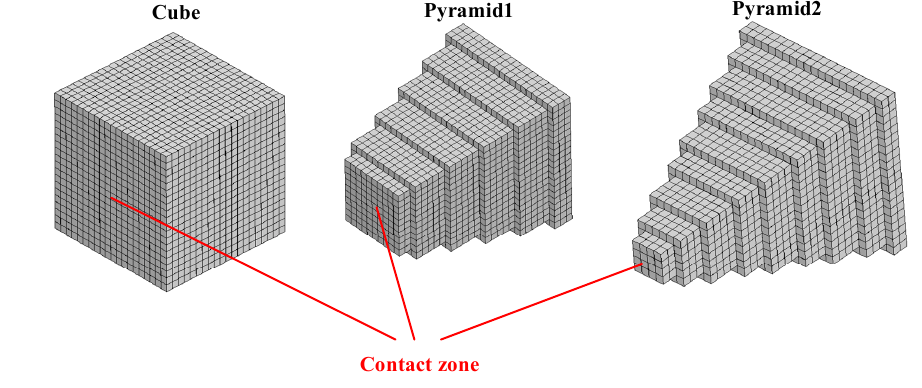
J. Mar. Sci. Eng. 2019 , 7 , x FOR PEER REVIEW Figure 27. The models of three blocks with di ff erent shapes. Figure 27. The models of three blocks with different shapes.